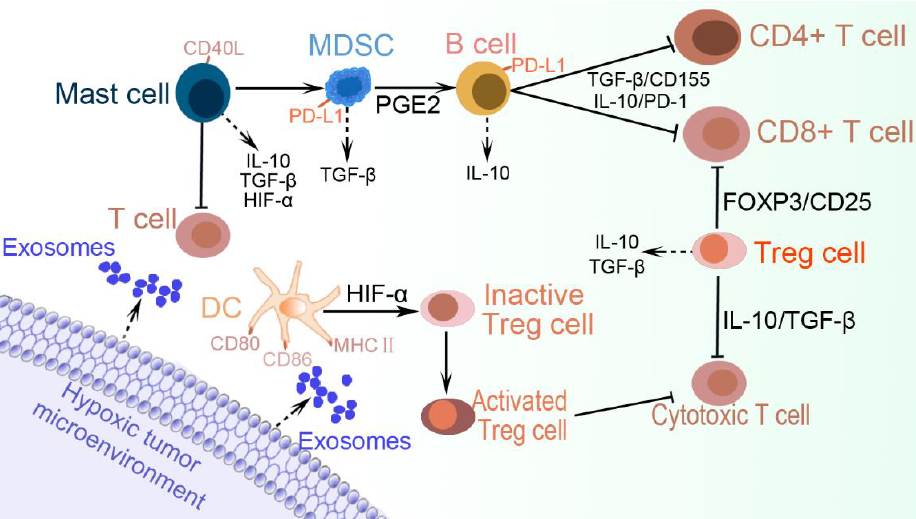
Figure 5. Tumor immune evasion via increased recruitment of tumor-promoting immune cells. The hypoxic TME expresses exosomes that upregulate the activation of anti-inflammatory cells including MDSCs and Tregs, and their associated cytokines, such as IL10, TGF- β , and HIF-1 α , among other surface recognition molecules that together facilitate tumor cell immune evasion. Certain phenotypes of DCs and mast cells increase the activation of Tregs and MDSCs, respectively. MDSCs further induce B cells via PGE2 to secret IL10 and deactivate both CD8+ and CD4+ T cells, while Tregs and mast cells also inhibit cytotoxic T cells. The increased recruitment, activation, and expansion of these tumor-friendly cells provide the conducive microenvironment needed for immune evasion and tumor